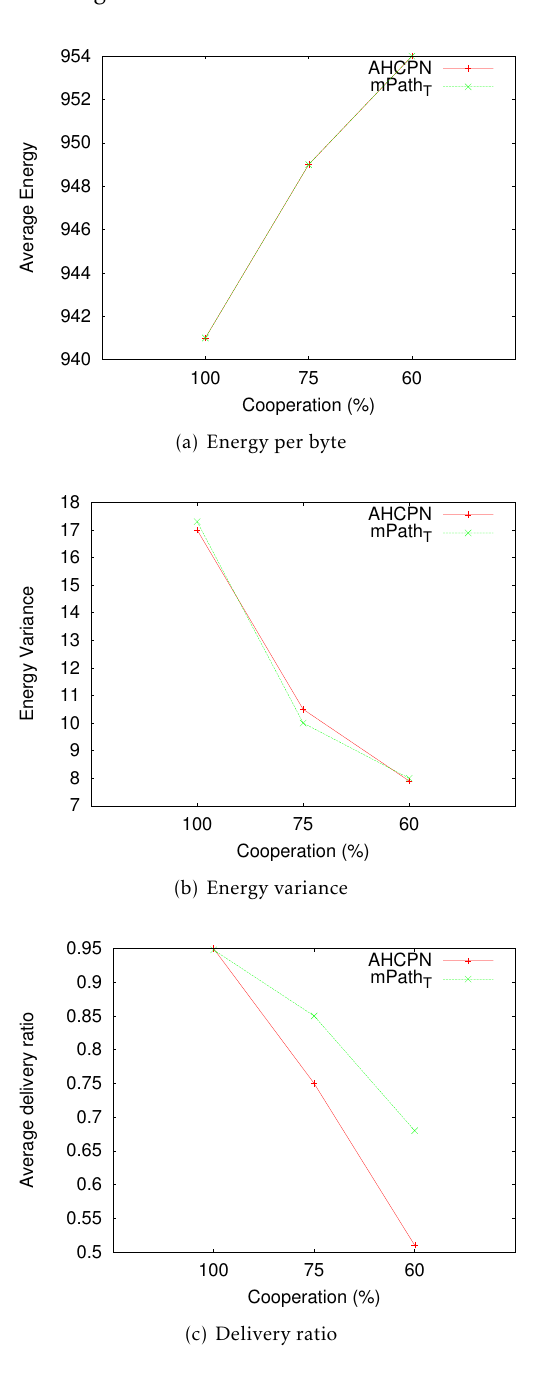
Figure 6. Average